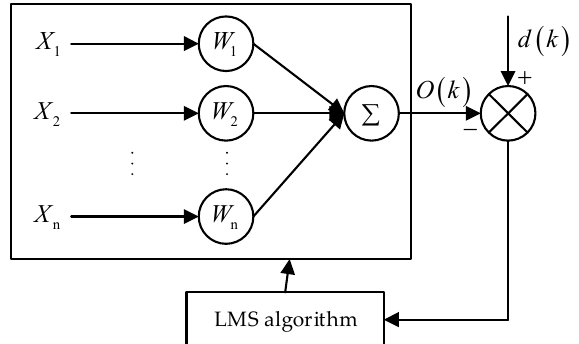
Figure 2. Adaline neural network structure diagram.